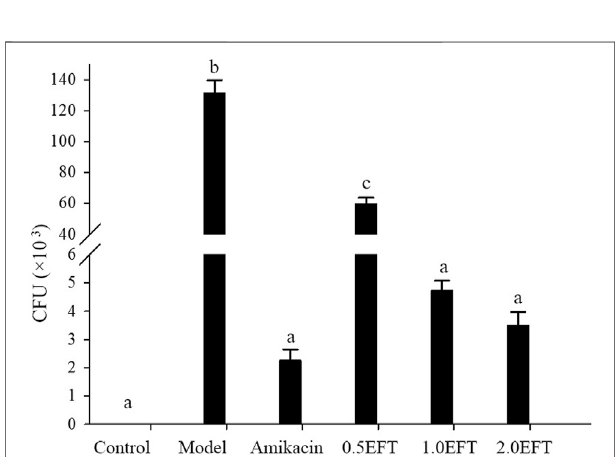
FIGURE 5 | Colony counts in BALFs of mice in each group were collectedforculturing,andthenumber ofbacterialcolonieswascounted 24 h later ( n (cid:2) 12). Different English letters in the same column represented a signi fi cant difference through pair-wise comparison by the LSD multiple comparison test ( p <